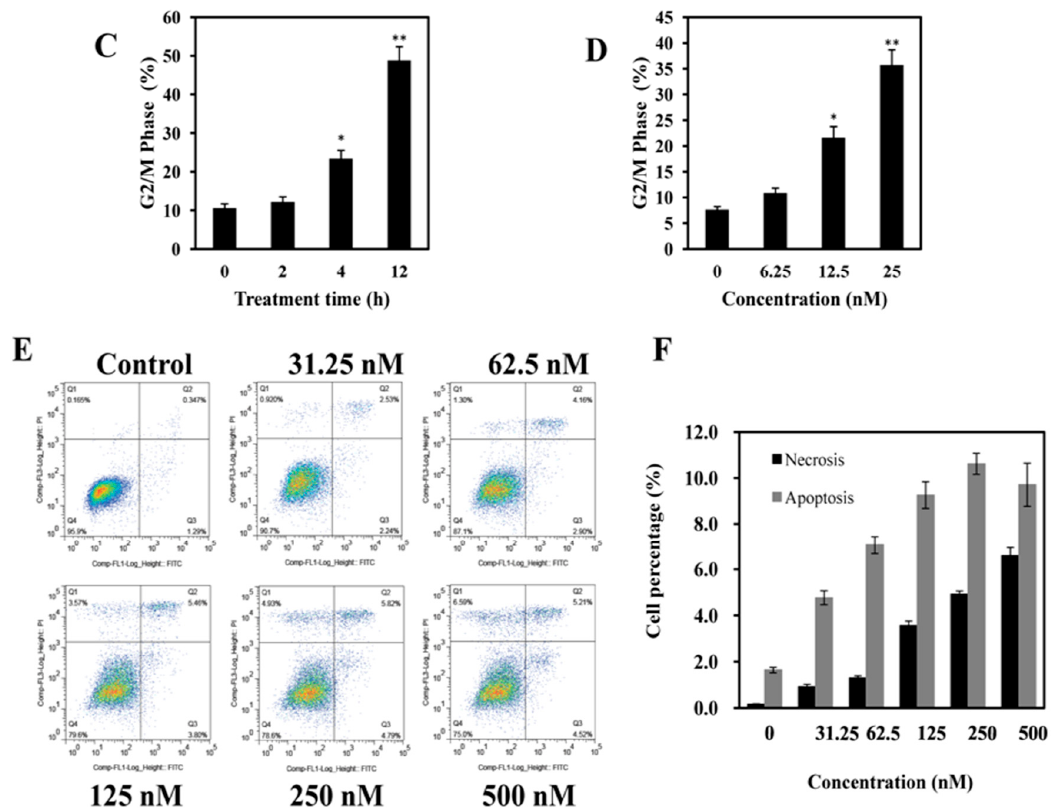
Figure 3. AAI induces G2/M phase arrest, apoptosis, and necrosis in K562 cells. ( A ) AAI time-dependently arrests K562 cells at G2/M phase. K562 cells were treated with 250 nM AAI for 0, 2, 4 and 12 h. Then, cells were collected, fixed, digestion with RNase A, and stained by PI. The DNA contents of the cells were determined with the Aria FACS flow cytometry system; red: G0/G1 or G2/M phase, blue: S phase; ( B ) K562 cells were treated with AAI (0–25 nM) for 24 h, and then the cell cycle distribution was analyzed; red: G0/G1 or G2/M phase, blue: S phase; ( C ) histograms show the percentage of cells distributed in G2/M phase after treated with 250 nM AAI for 0, 2, 4 and 12 h; * p < 0.05, ** p < 0.01 versus control; ( D ) histograms show the percentage of cells distributed in G2/M phase after treated with AAI (0–25 nM) for 24 h; * p < 0.05, ** p < 0.01 versus control; ( E ) AAI induces both apoptosis and necrosis in K562 cells. K562 cells were untreated or treated with 31.25, 62.5, 125, 250 and 500 nM AAI for 18 h, and then the cells were double-stained with Annexin V-FITC/PI and analyzed by flow cytometry. The percentage of Annexin V-FITC positive cells and/or PI positive cells is indicated; and ( F ) histogram shows the percentage of necrosis and apoptosis in K562 cells induced by AAI.